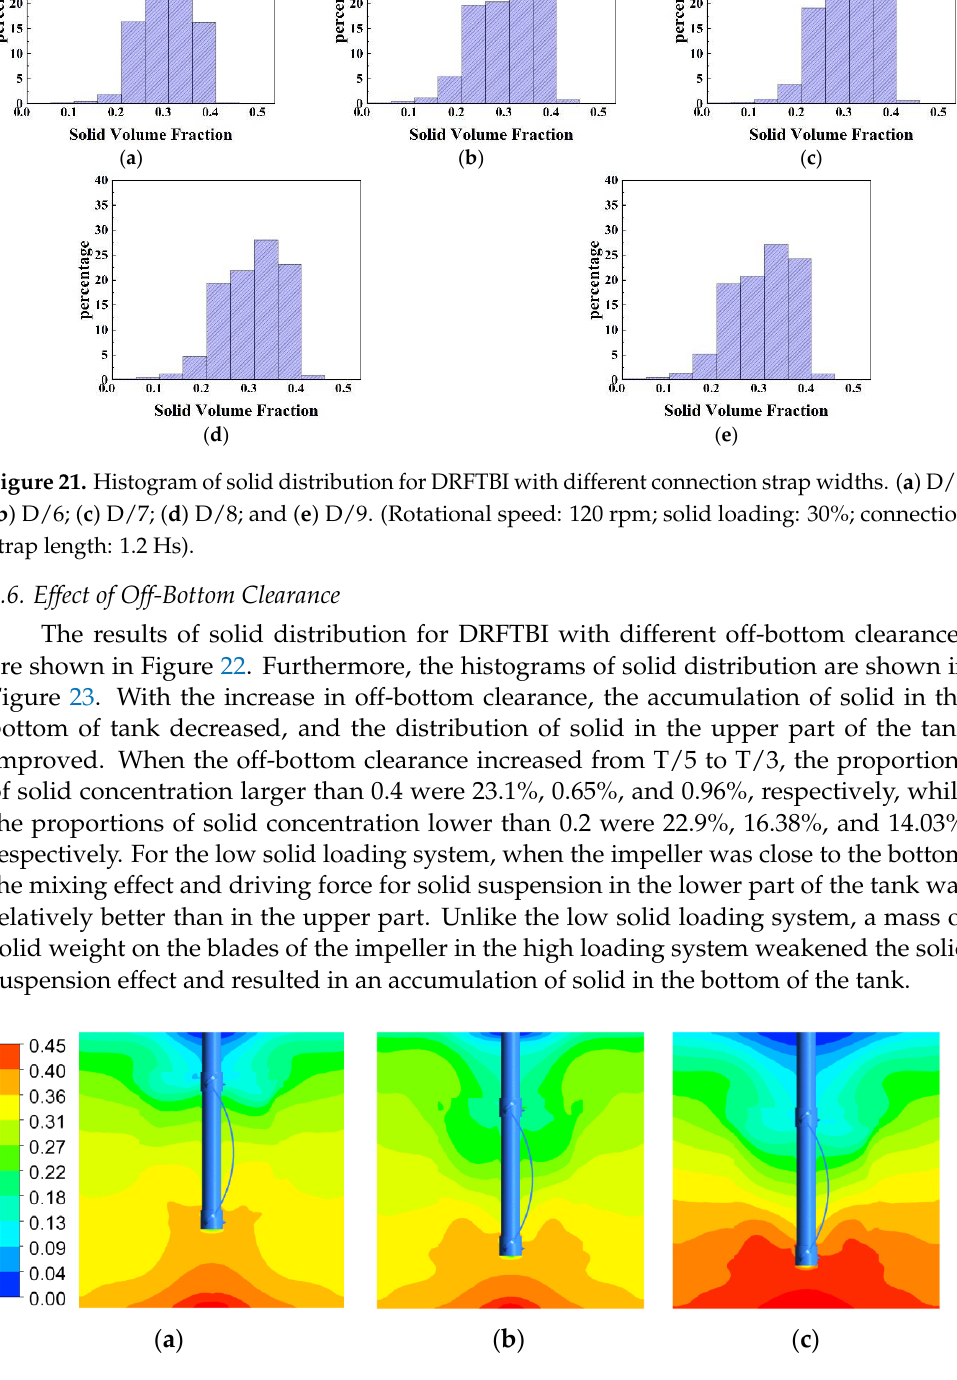
Figure 22. Contour plots of solid distribution for DRFTBI with different off-bottom clearance. ( a ) T/3; ( b ) T/4; and ( c ) T/5. (Rotational speed: 120 rpm; solid loading: 30%; connection strap length: 1.2 Hs).